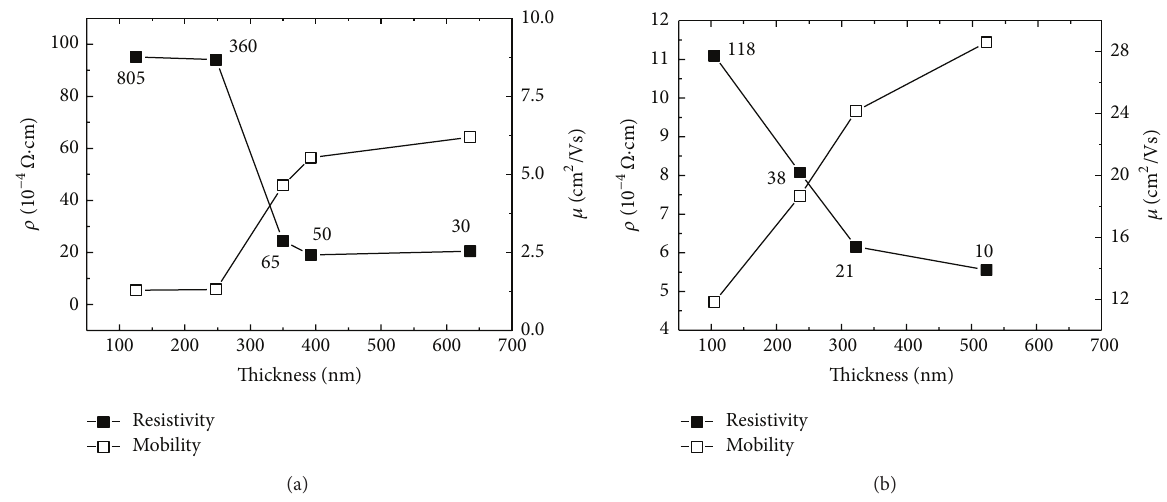
Figure 1: Variation of resistivity, 𝜌 , and mobility, 𝜇 , as a function of ETP-CVD ZnO:Al layer thickness for (a) low thermal budget and (b) high thermal budget conditions. Note that resistivity of the sputtered ZnO:Al films (650nm thick, used for the reference cell) was ∼ 8 × 10 −4 Ω⋅ cm. Sheet resistances ( Ω/◻ ) are indicated next to the resistivity data points.